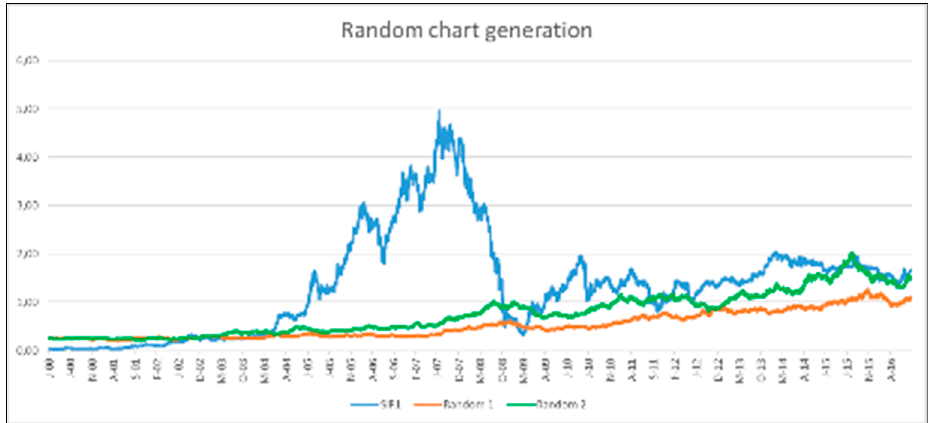
Figure 13. SIF1 chart, compared with randomly generated titles. Source: Authors’ processing is based on data available on www.bvb.ro (accessed on 10.12.2018).